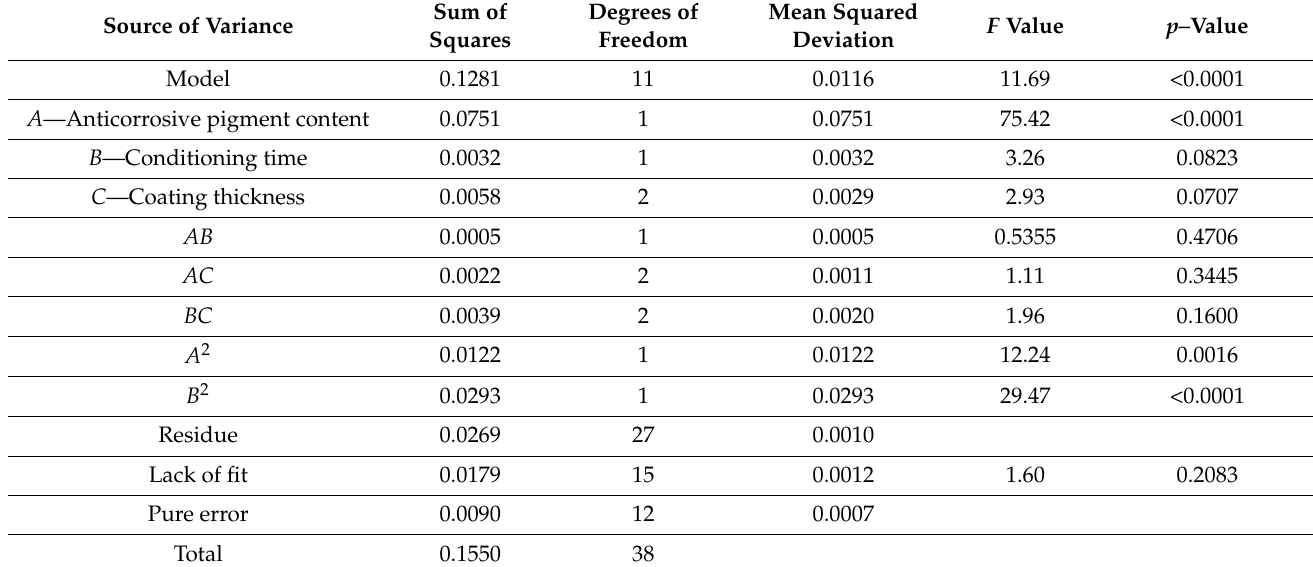
Table 5. Analysis of variance for the regression model for notch corrosion after 120 h in the salt-spray test